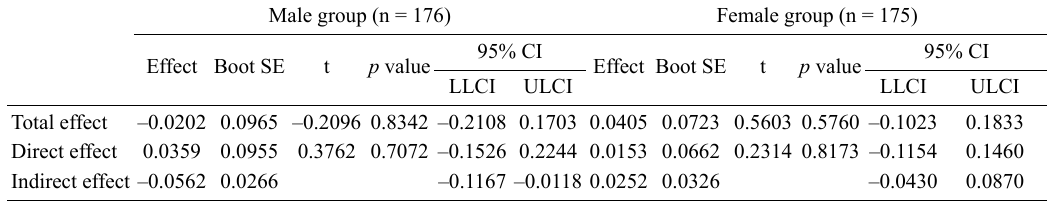
Table 4. Effects on BMI and depression with physical health as a